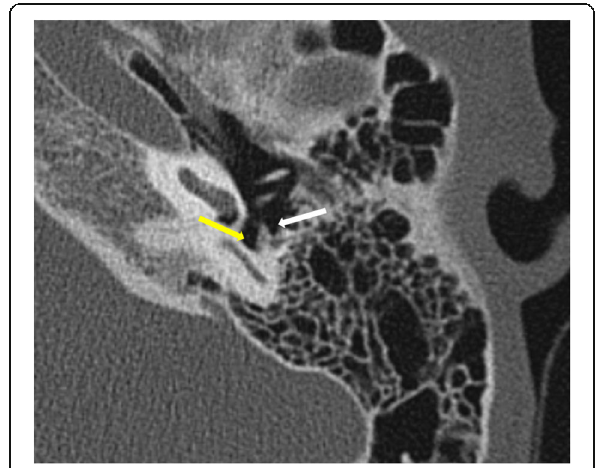
Fig. 5 Axial CT through the mesotympanum shows the sinus tympani (yellow arrow) and facial recess (white arrow) which are hidden areas by otological examination and should be carefully inspected on imaging for the presence of soft tissue.